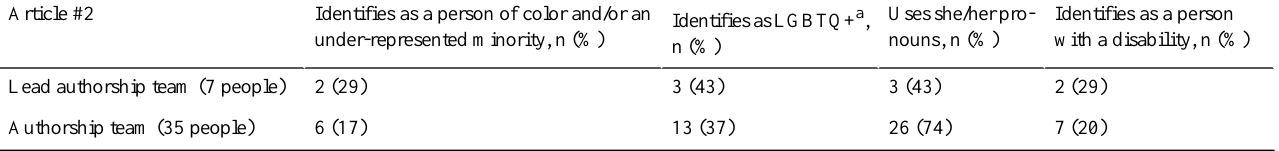
Table 2. Authorship team composition for article #2.